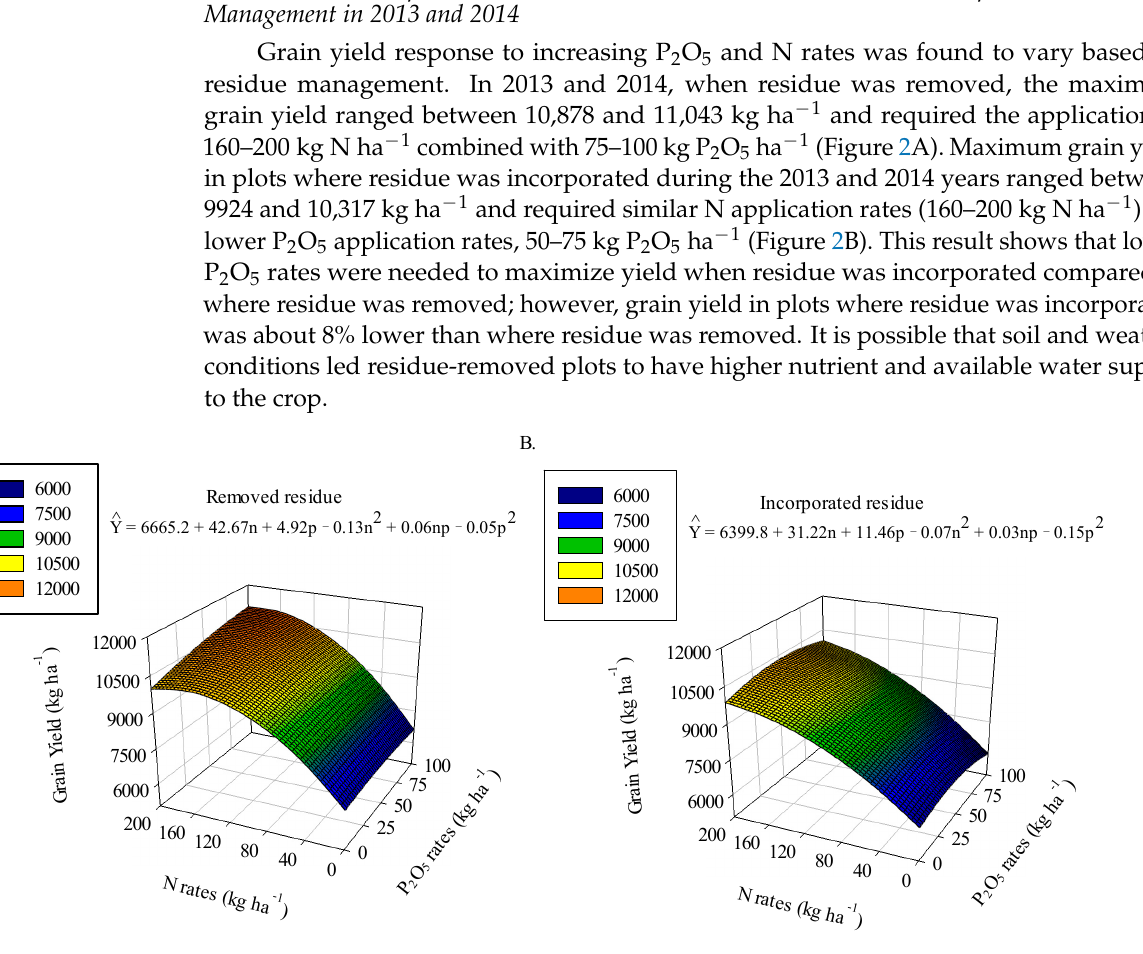
Table 1. Grain N, P, K, Ca, Mg, and S accumulation and biomass N, Ca, S accumulation in 2013, 2014, and 2015 as a function of N application rates.